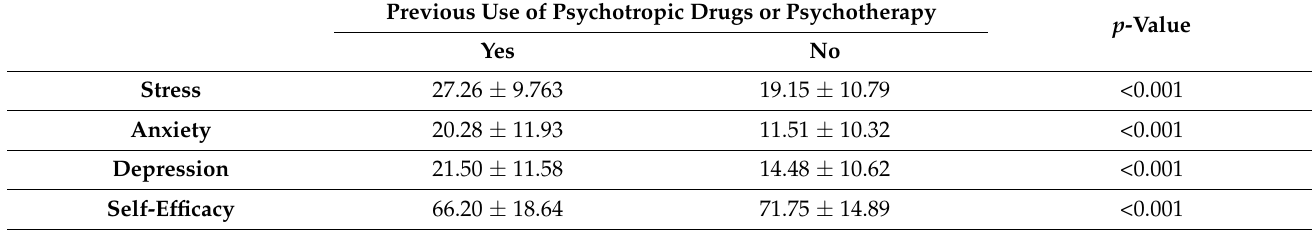
Table 2. Level of stress, anxiety, depression, and self-efficacy according to previous use of psy- chotropic drugs or